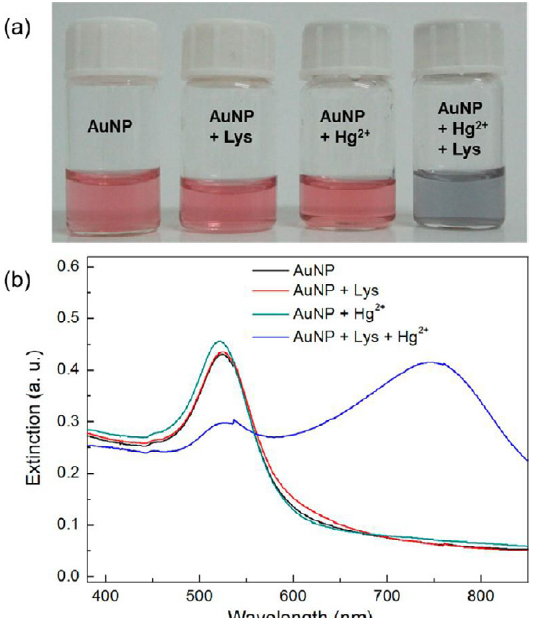
Fig. 2. Colorimetric response of the assay. (a) Photographs of AuNP solutions showing that the color change occurs only in the presence of lysine (0.4 mM) and Hg 2+ (10 μM). (b) Extinction spectra of the AuNP solutions. Reprinted with permission from ref. 56, Copy right 2014 American Chemical Society.